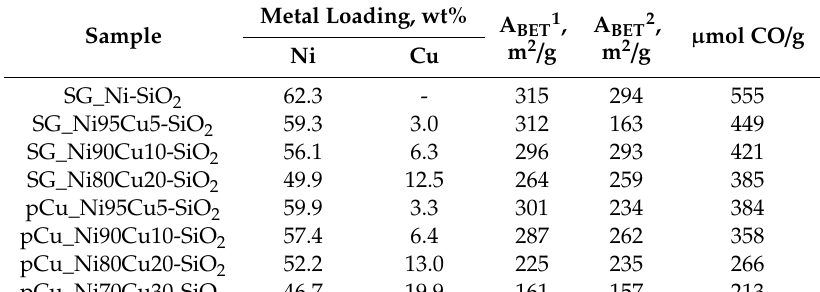
Table 1. Catalyst composition in the oxidized state, Brunauer–Emmett–Teller specific surface area of the catalysts in oxidized (A BET1 ) and reduced form (A BET2 ), and CO chemisorption onto the reduced catalysts.